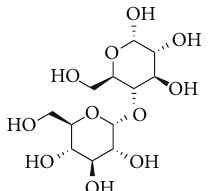
Figure 1: Polymer classi fi cation [11].